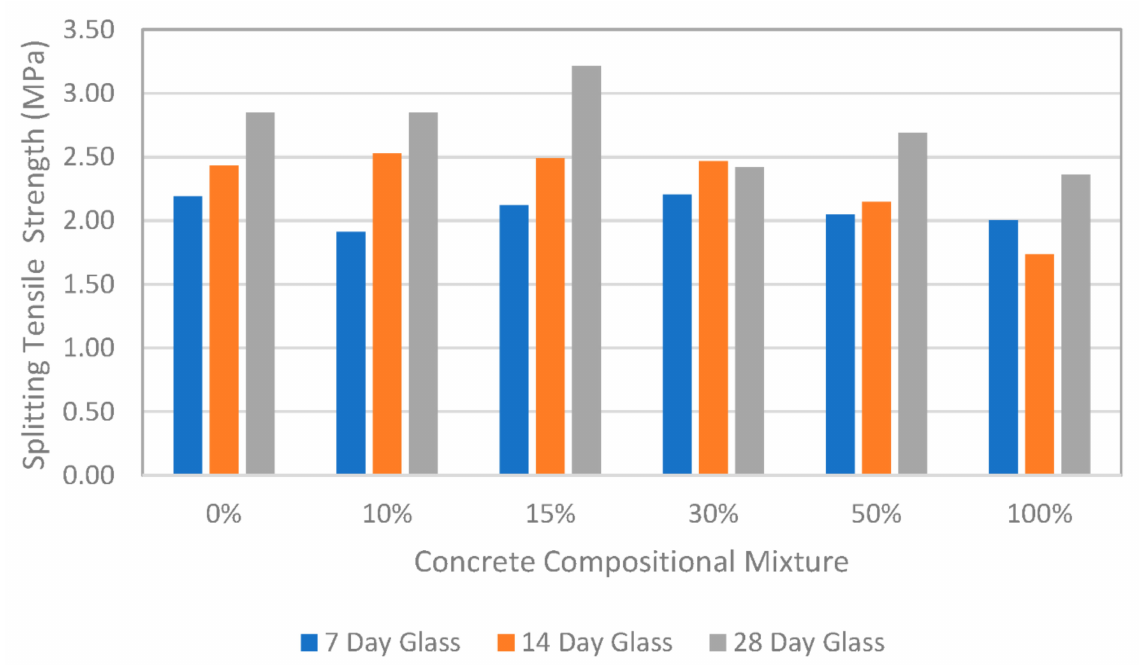
Figure 14. Effect of proportions CWG on splitting tensile strength of concrete samples.